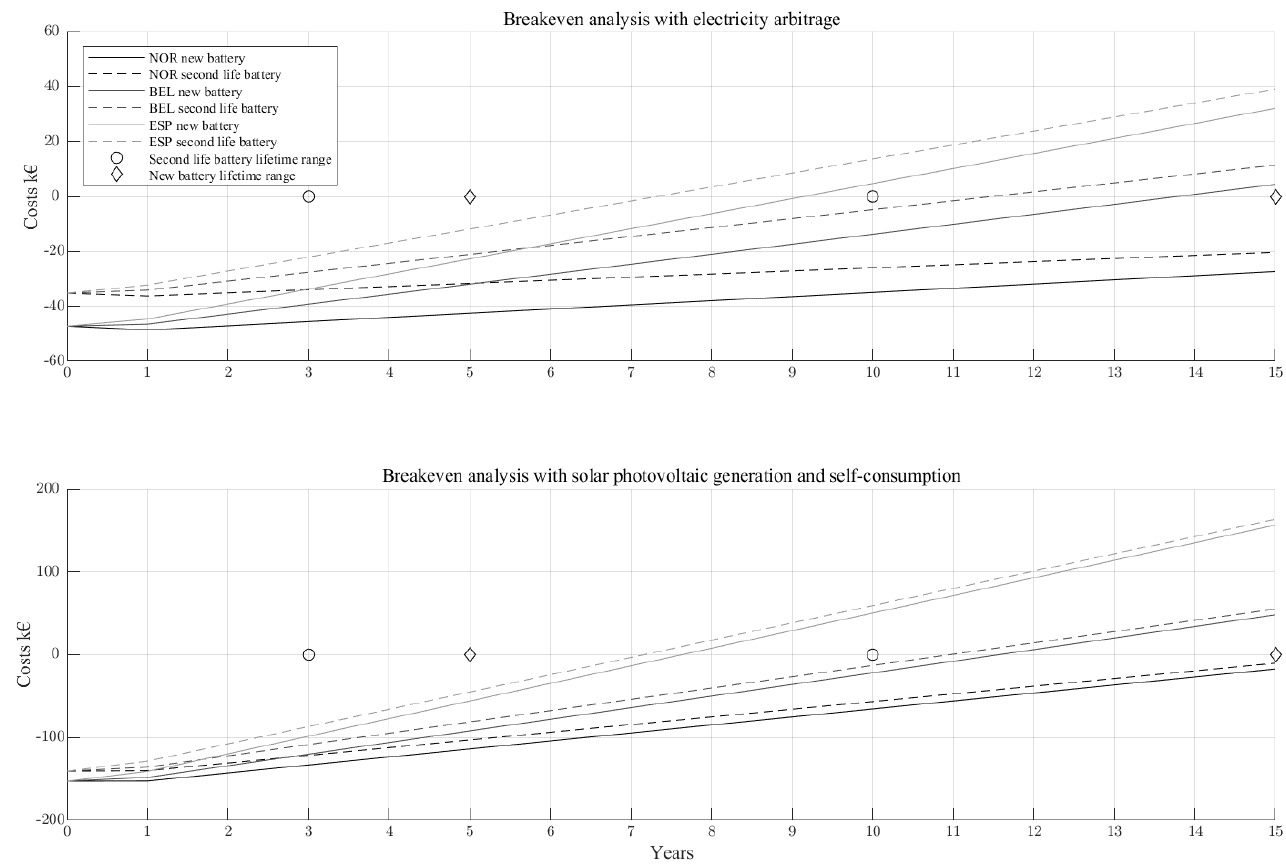
Figure 4. Breakeven points for battery investment scenarios for Norway (NOR), Belgium (BEL), and Spain (ESP), and estimated cycle lifetime range for a new and second life battery.